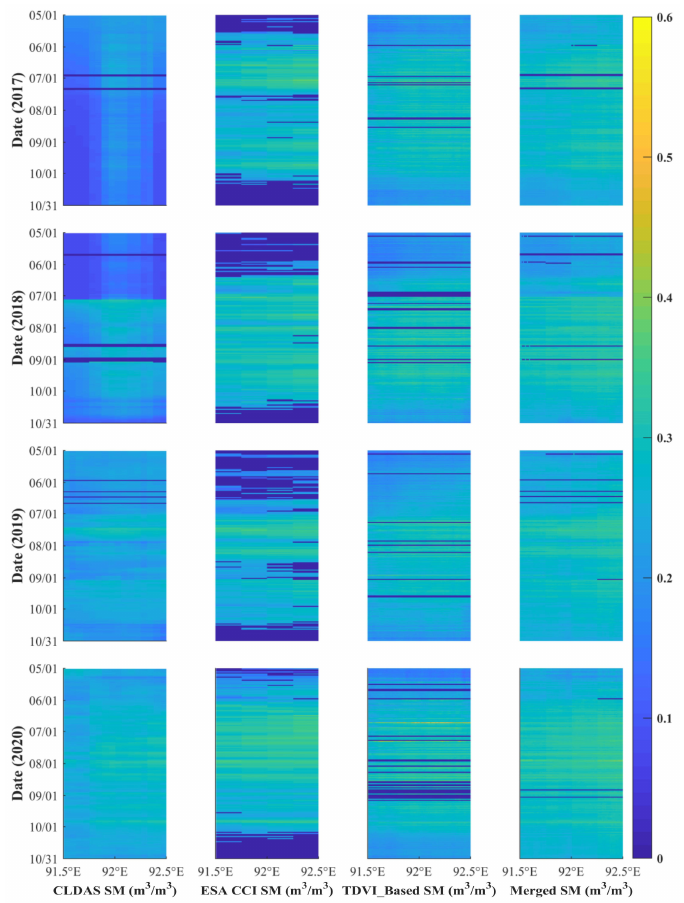
Figure 7. Hovmöller (time-longitude) diagrams of CLDAS, ESA CCI combined, TDVI-based, and merged SM products during the study period (every May to October from 2017 to